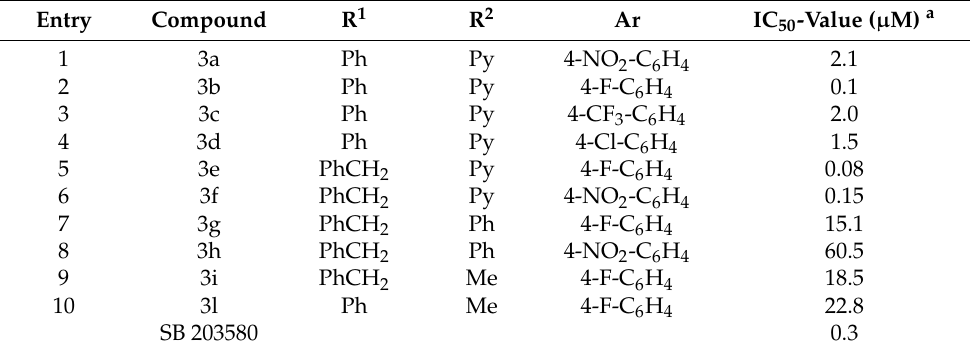
Table 2. IC 50 values for synthesized compounds 3a–l in p38 α MAP kinase